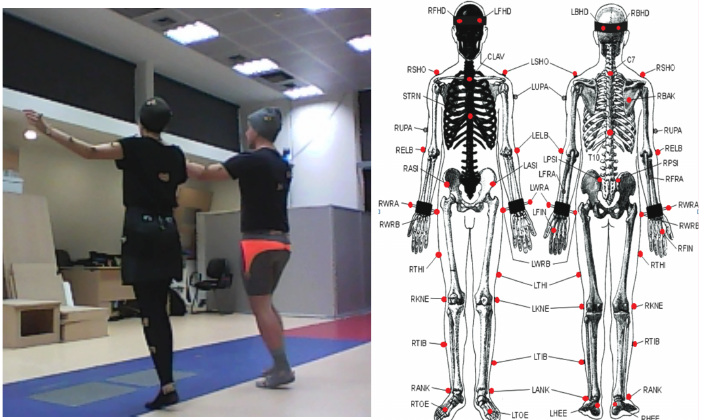
Figure 6. The motion capturing process takes into consideration the appropriate topology of the passive markers according to the VICON manual. 40 passive markers have been attached to the body of each